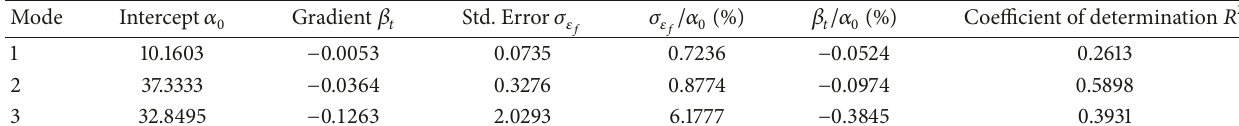
Table 7: Coefficients of linear regression model (frequency ∼ humidity) of girder No. 3.